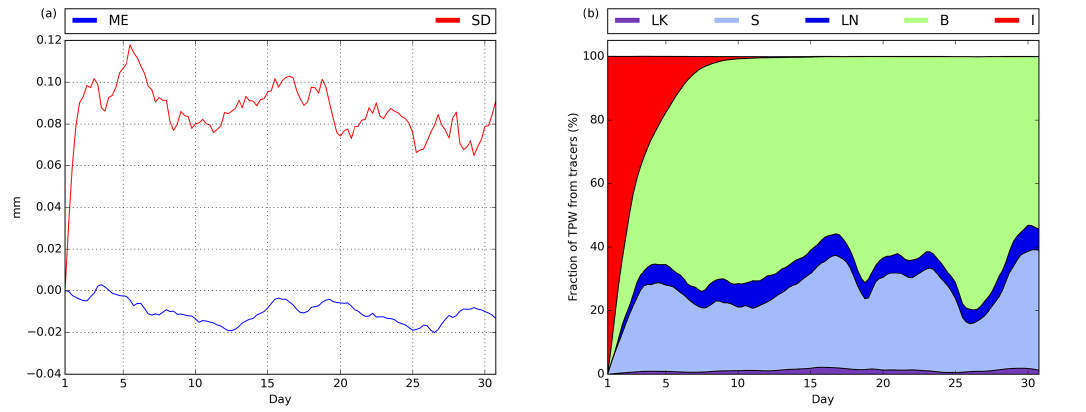
Figure 7. Same as Fig. 6 but for TPW